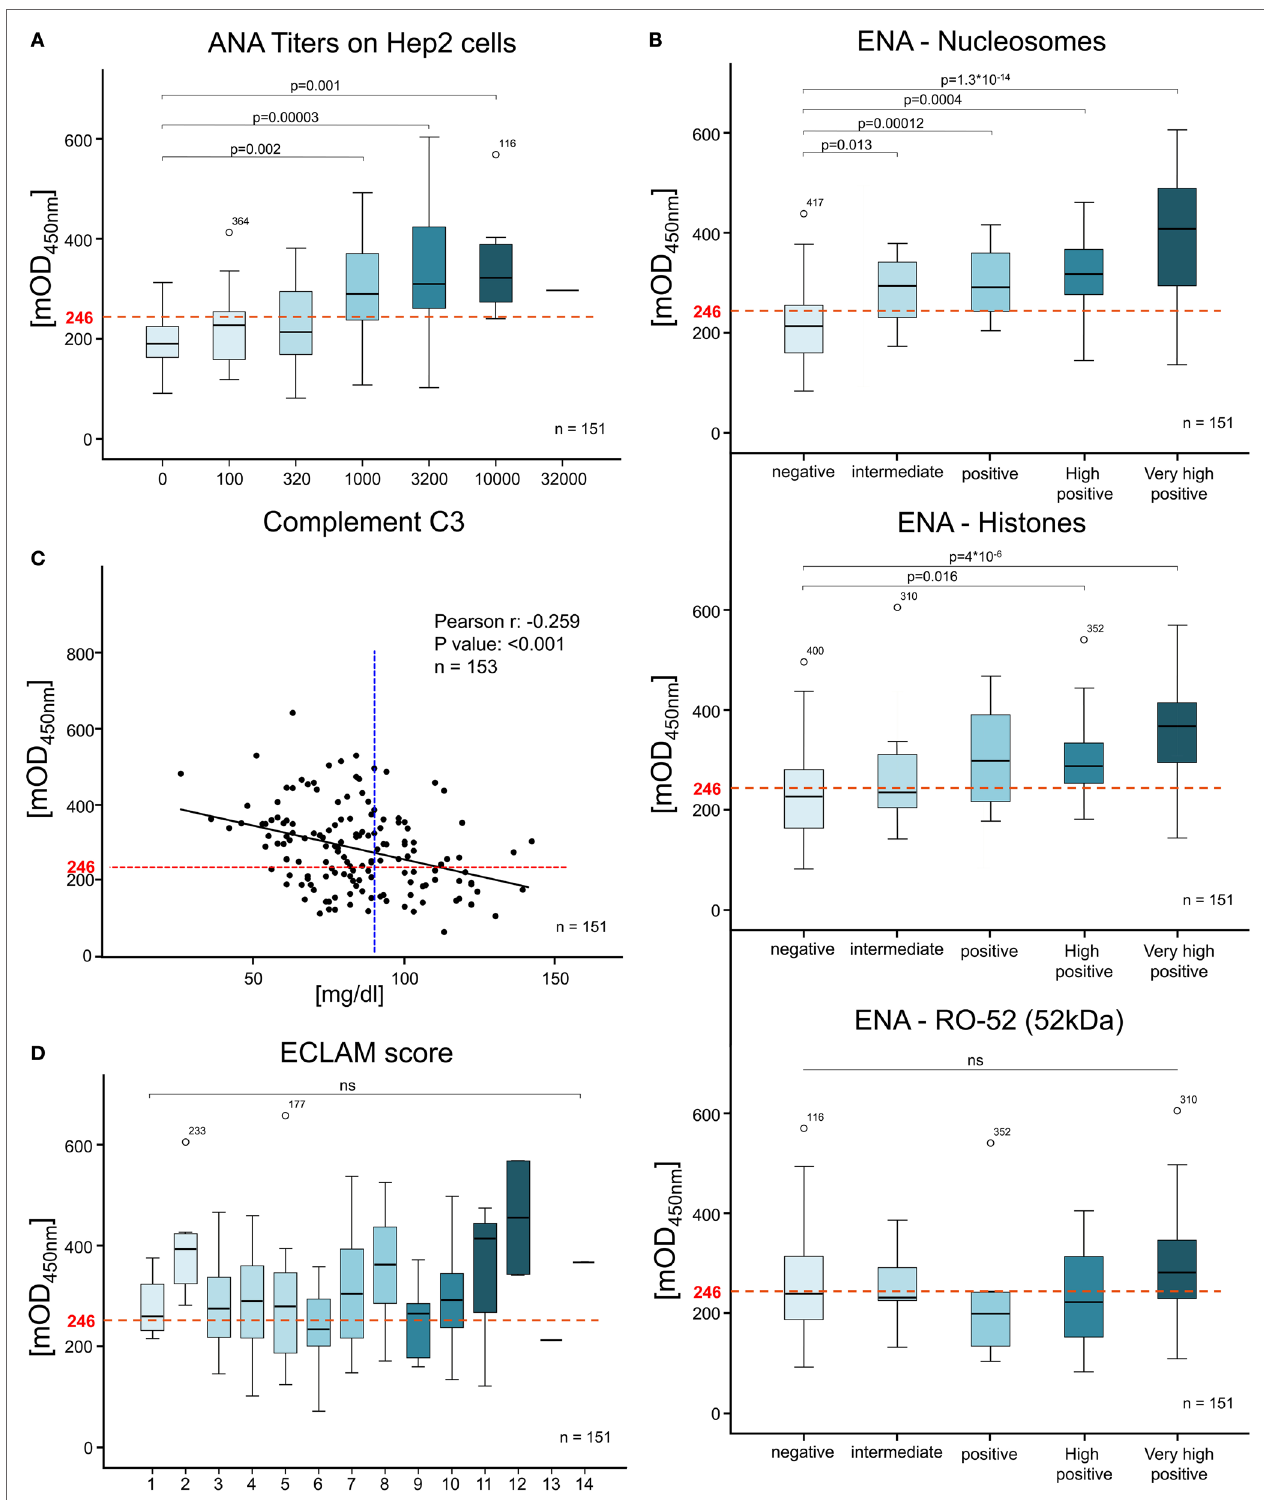
FigUre 3 | Anti-secondary NEcrotic cell (SNEC) IgG correlates with serological disease variables but not with the disease activity. The correlation of SNEC ELISA levels with serological and clinical variables was evaluated by Bravais-Pearson correlation coefficients and corrected after Bonferroni. SNEC positivity was compared to (a) anti-nuclear antigen on HEp-2 cell titers, (B) extractable nuclear antigen positivity (Nucleosomes, Histones, Ro52), (c) Complement C3 levels (cut off C3 levels at 90 mg/ml indicated as blue dotted line), (D) European Consensus Lupus Activity Measurement Manifestation Score and others (see also Tables 1, 2 and S1, S2 in Supplementary Material). The SNEC ELISA cut-off at 246 mean optical density is depicted as a red dotted